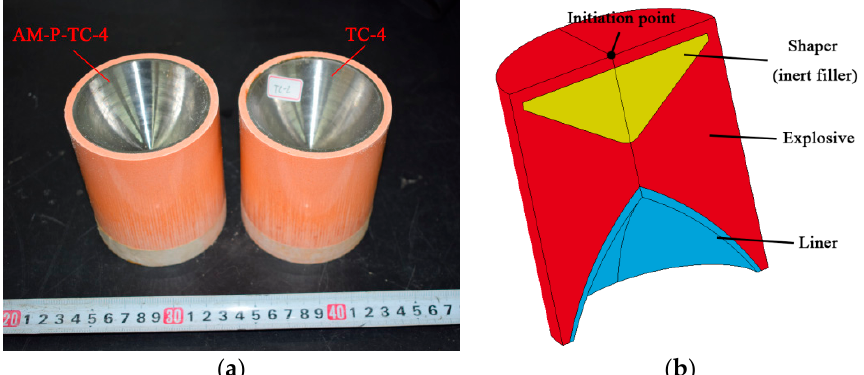
Figure 16. Shaped-charge warheads: ( a ) TC-4 and AM-P-TC-4 warheads; ( b ) structure diagram of shaped-charge warhead.